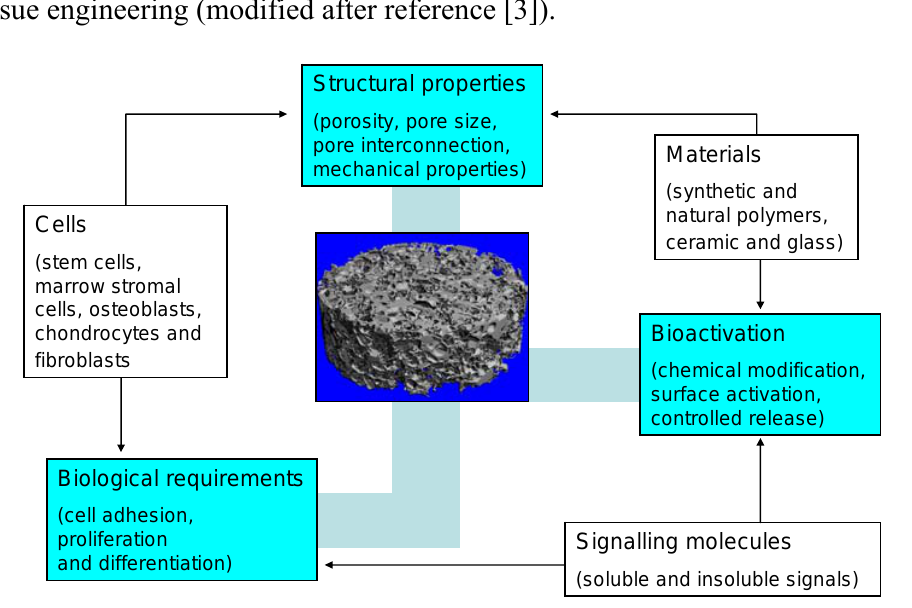
Figure 2. Schematic diagram of key factors involved in the design of optimal scaffolds for bone tissue engineering (modified after reference